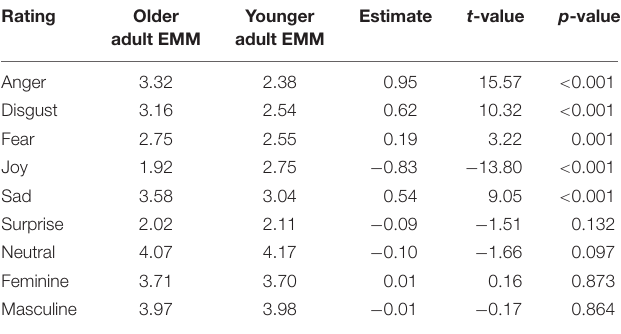
TABLE 2 | Pairwise comparisons for Study 2.